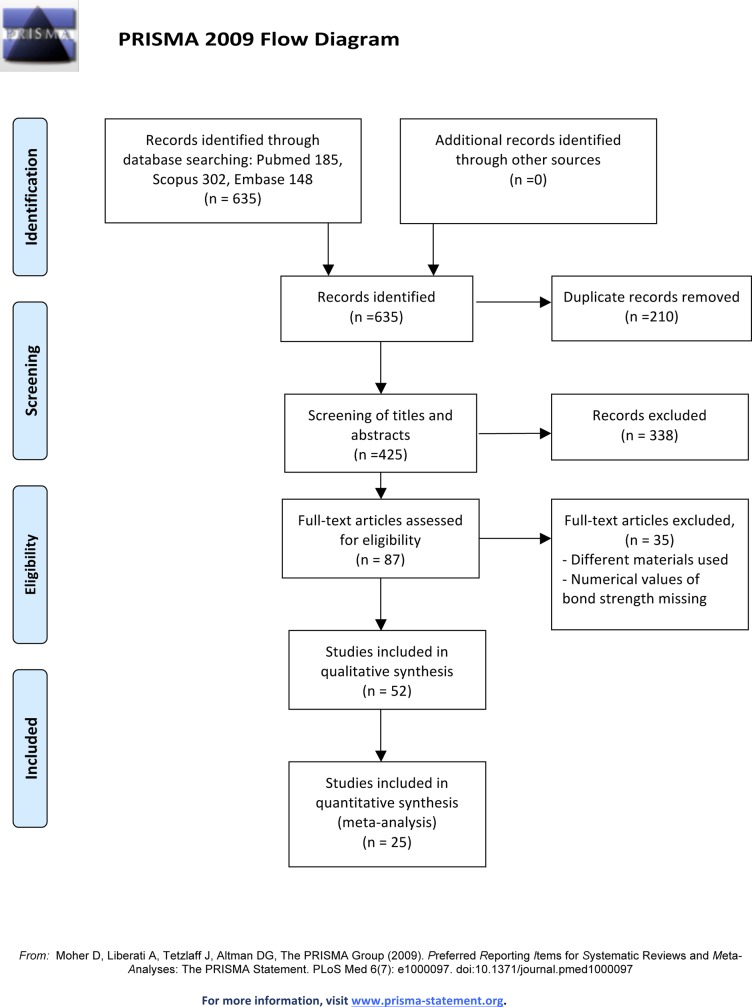
The PRISMA flow diagram.From: Moher D, Liberati A, Tetzlaff J, Altman DG, The PRISMA Group (2009). Preferred Reporting Items for Systematic Reviews and Meta-Analyses: The PRISMA Statement.